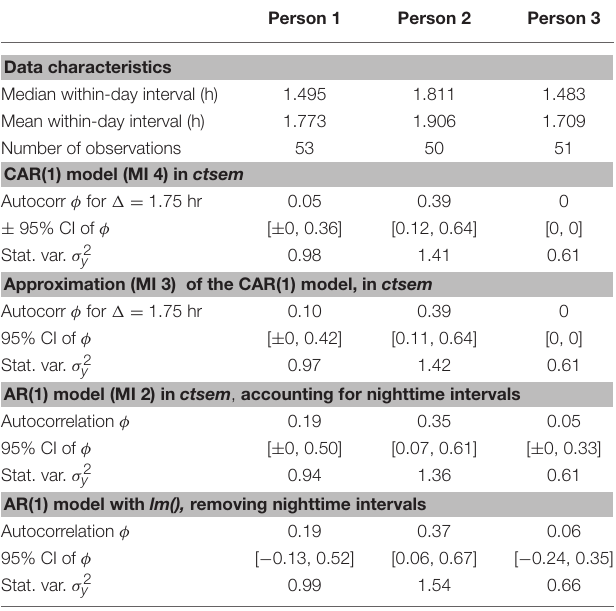
TABLE 2 | Data characteristics and parameter estimates under four model implementations for the PA of the three adolescents in our empirical example. Person 1 Person 2 Person